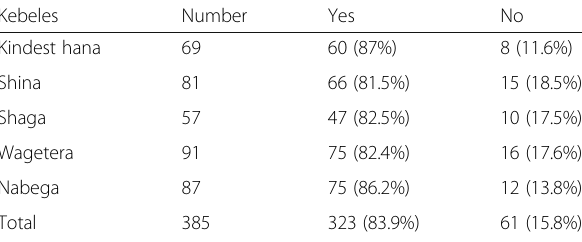
Table 5 The response of farmers on the effect of rice production on Fogera cattle population reduction